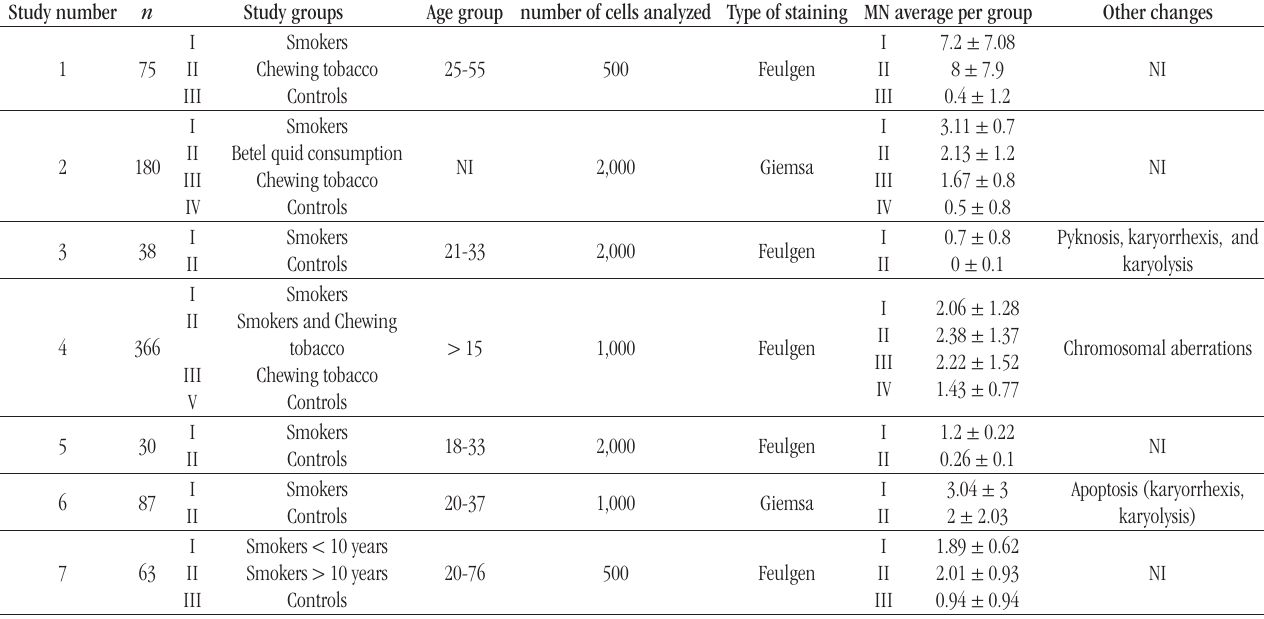
table 2 – Methodological characteristics and results of selected studies from 1 to 7